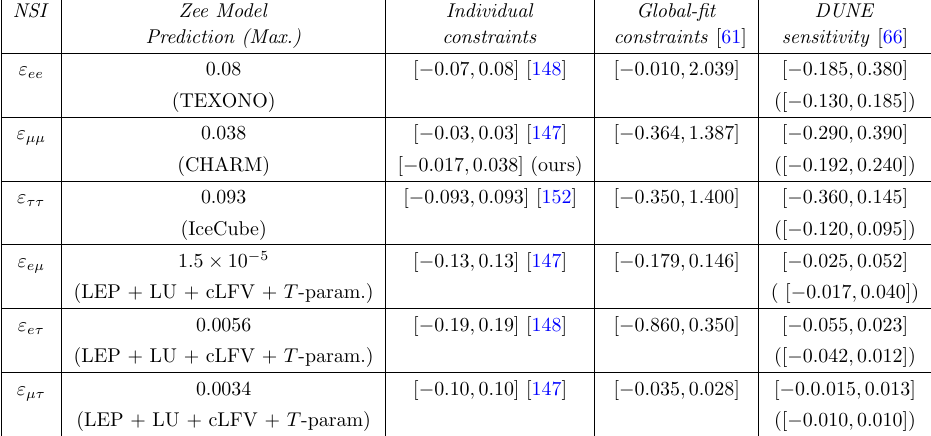
Table 9 . Maximum allowed NSI (with electrons) in the Zee model, after imposing constraints from CBM (section 4.3), T -parameter (section 4.4), cLFV searches (section 4.5), LEP contact in- teraction (section 4.6), direct collider searches (section 4.7), lepton universality (LU) in W